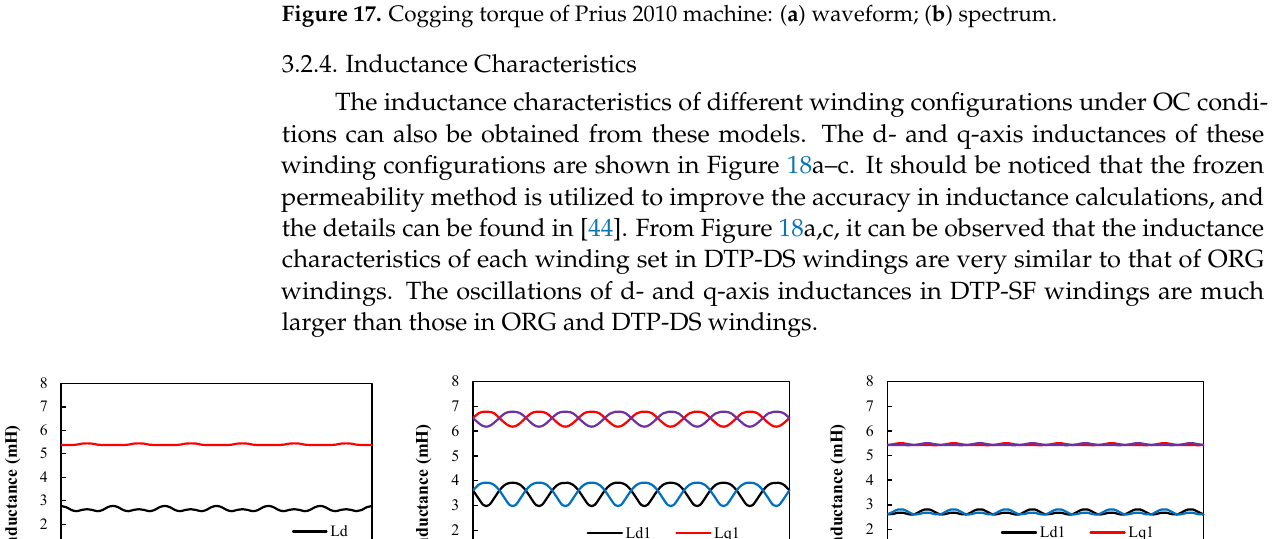
Rotor position (Elec. deg.) Figure 17. Cogging torque of Prius 2010 machine: ( a ) waveform; ( b ) spectrum.